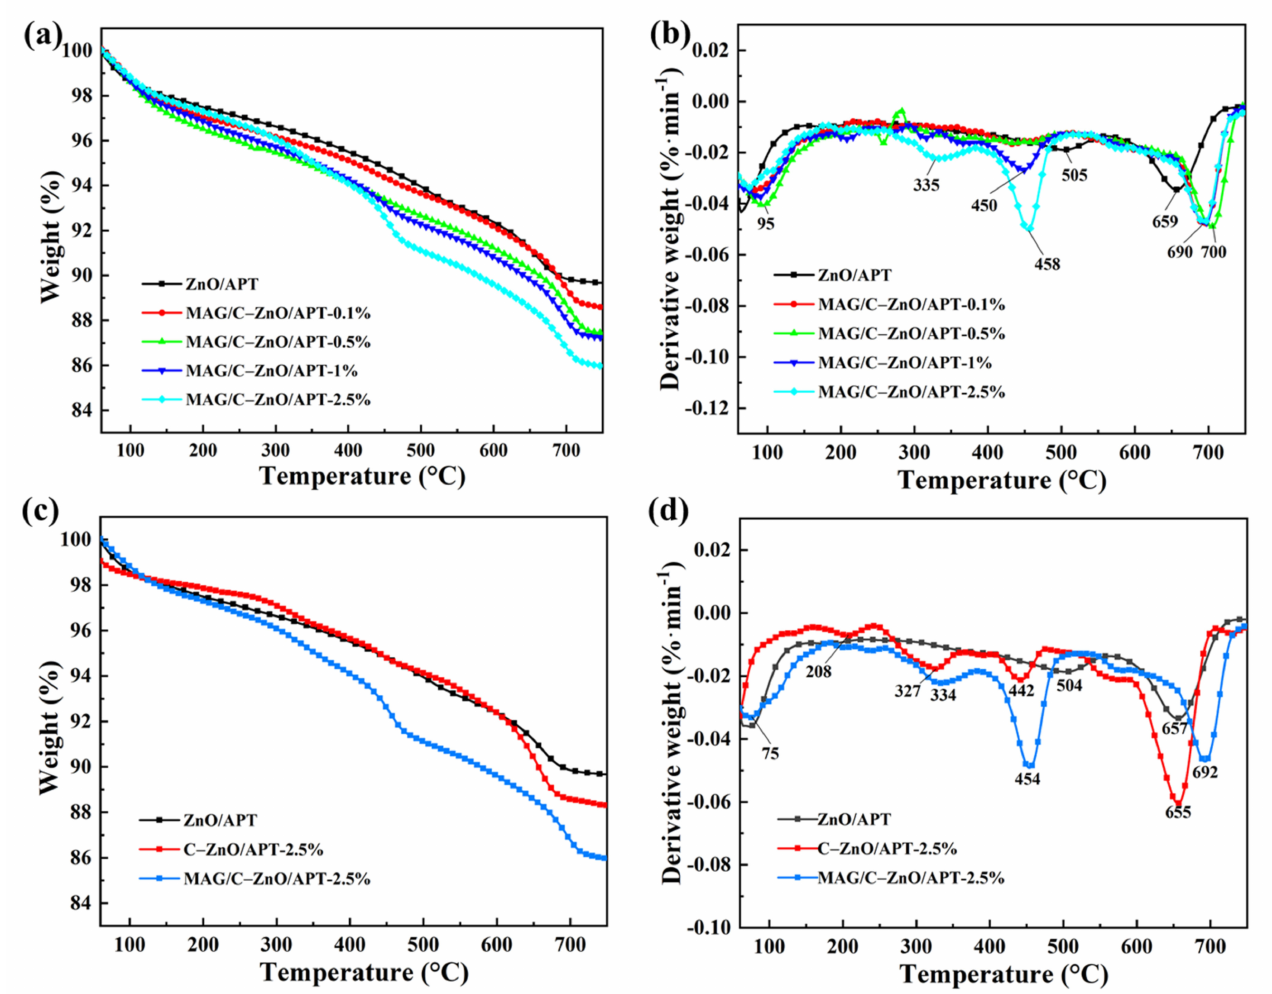
Figure 4. TGA ( a ) and DTG ( b ) curves of ZnO/APTand MAG/C–ZnO/APT nanocomposites; TGA ( c ) and DTG ( d ) curves of ZnO/APT, C–ZnO/APT-2.5% and